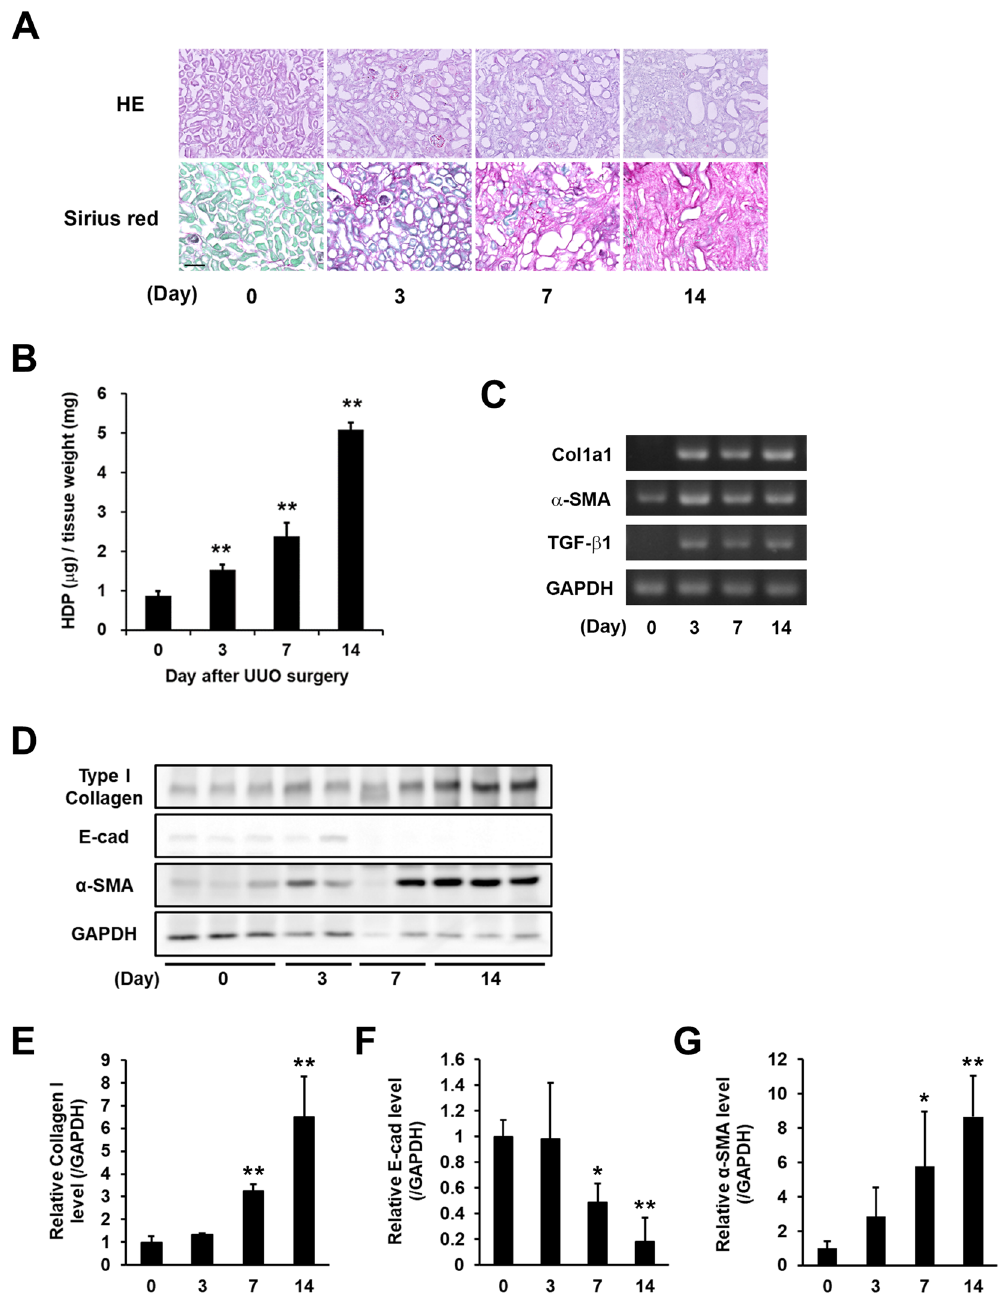
Figure 1. Evaluation of the fibrotic markers in kidney fibrosis after UUO surgery. UUO was induced in mice by ligating the left ureter in 8 weeks-old ICR mice. The mice were then sacrificed on days 3, 7, and 14 after surgery ( n = 7–10 mice per group). ( A ) Kidney sections were fixed in 4% paraformaldehyde, and then stained using H&E and Sirius Red (using the Sirius Red Collagen Detection Kit). The red and green colors indicate the fibrillar collagen (type I to V collagen) and non-collagenous protein, respectively. Bar = 100 μ m. ( B ) Hydroxyproline (HDP) contents were evaluated in the kidney on each indicated day after UUO surgery. The data are presented as the mean ± SD ( n = 3) ( ** P < 0.01, Student’s t -test). ( C ) The mRNA expression levels of the fibrotic markers (Collagen I α 1 (Col1a1), α -SMA, TGF- β 1, and GAPDH) were confirmed by RT-PCR. The full-length gel is presented in Fig. S1. ( D ) The protein levels in the whole lysate from the kidney tissue were analyzed by immunoblotting using each indicated antibody and GAPDH as a loading control for each sample. The full-length gel is presented in Fig. S2. ( E – G ) Relative changes in the densitometric profiles of collagen I, E-cadherin (E-cad), and α -SMA from ( D ) are presented under corresponding bands after normalizing to the changes in GAPDH. The data are presented as the mean ± SD ( n = 4–5) ( ** P < 0.01, * P < 0.05, Student’s t